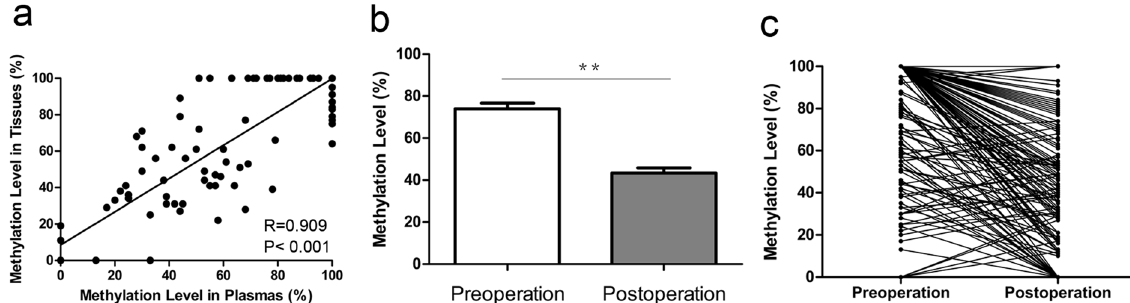
Figure 2. The reliability of MEG3 promoter methylation in plasma. ( a ) The level of MEG3 methylation in plasma presented a notable positive correlation with that in tissues of same patient. ( b , c ) A significantly higher methylation level was observed in DNA samples from preoperative plasmas as compared to postoperative plasmas. ** P < 0.01.